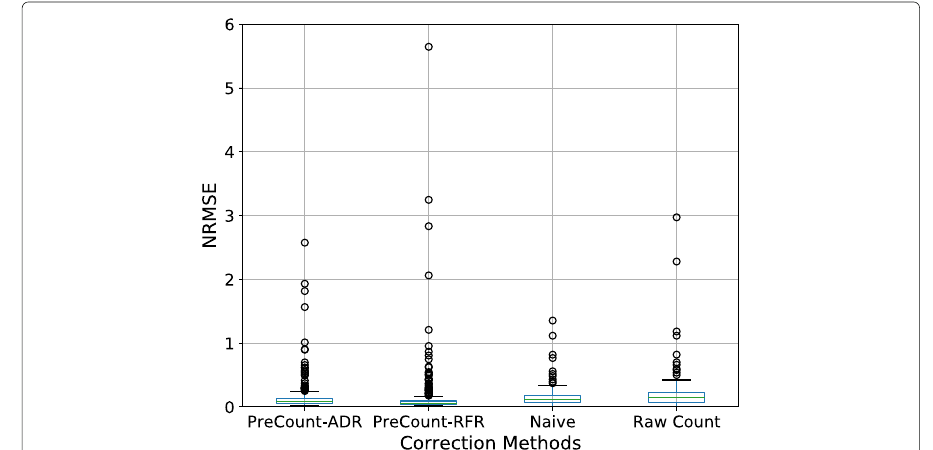
Fig. 7 Boxplot showing the performance of each correction method for MALL building